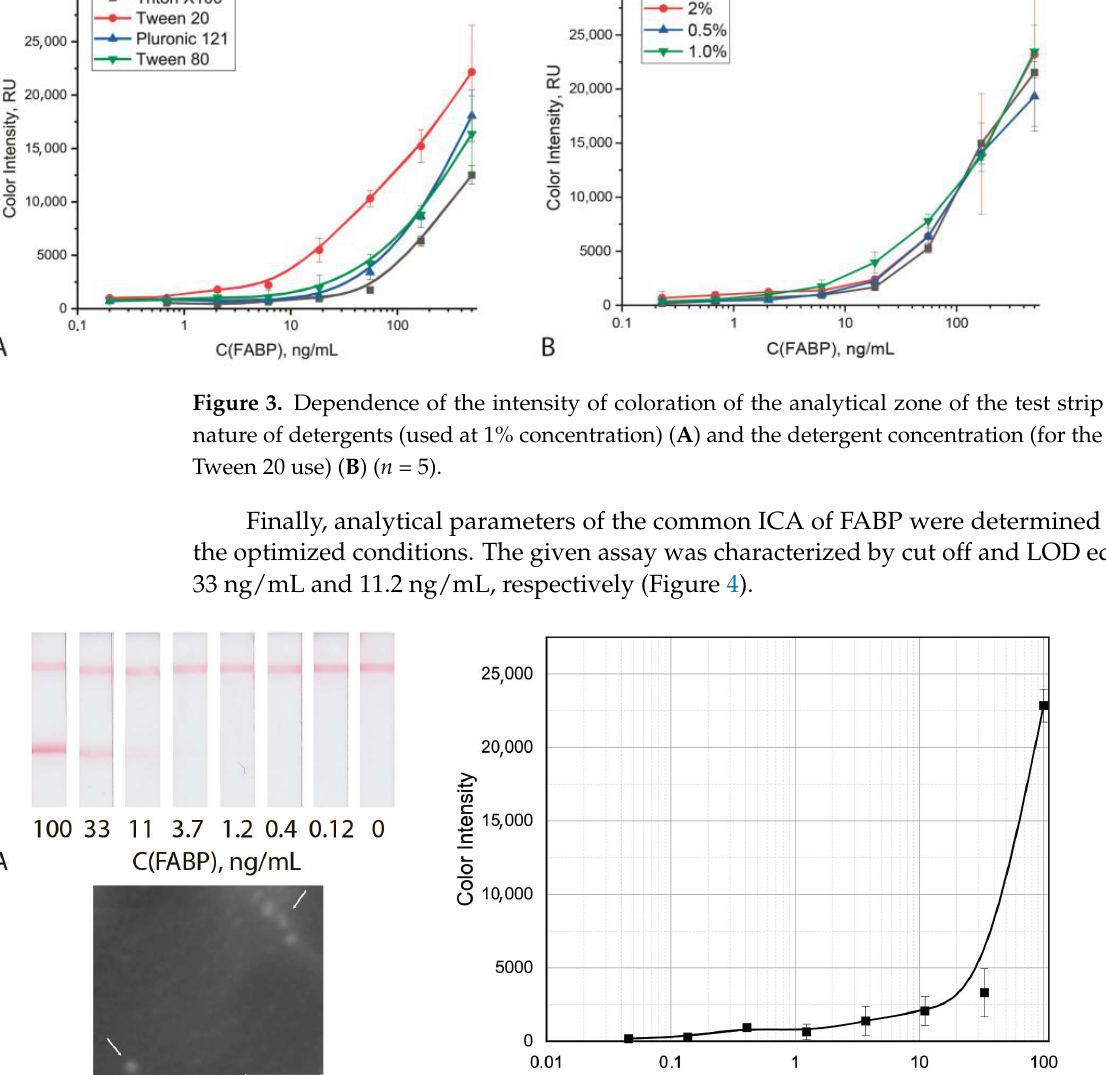
Figure 3. Dependence of the intensity of coloration of the analytical zone of the test strip on the nature of detergents (used at 1% concentration) ( A ) and the detergent concentration (for the case of Tween 20 use) ( B ) ( n = 5).